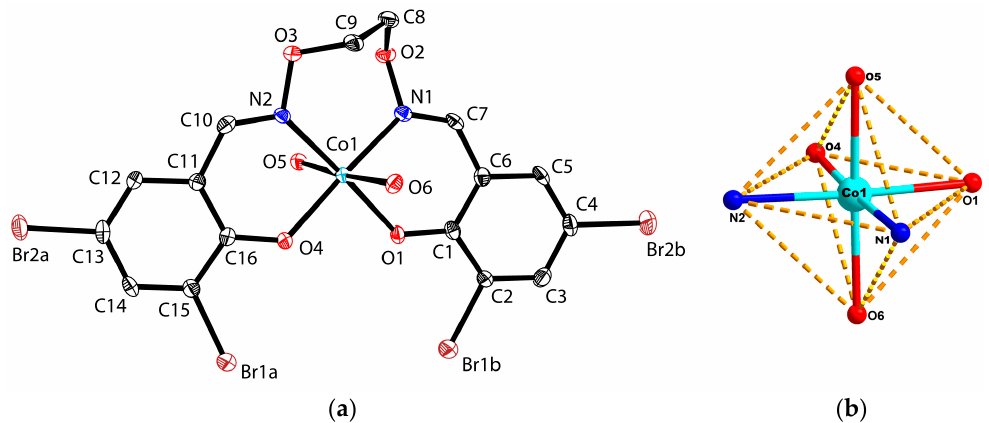
Figure 1. ( a ) Molecular structure and atom numberings of complex 1 with 30% probability displacement ellipsoids(hydrogen atoms are omitted for clarity); ( b ) Coordination polyhedron for Co(II) ion of complex 1 .